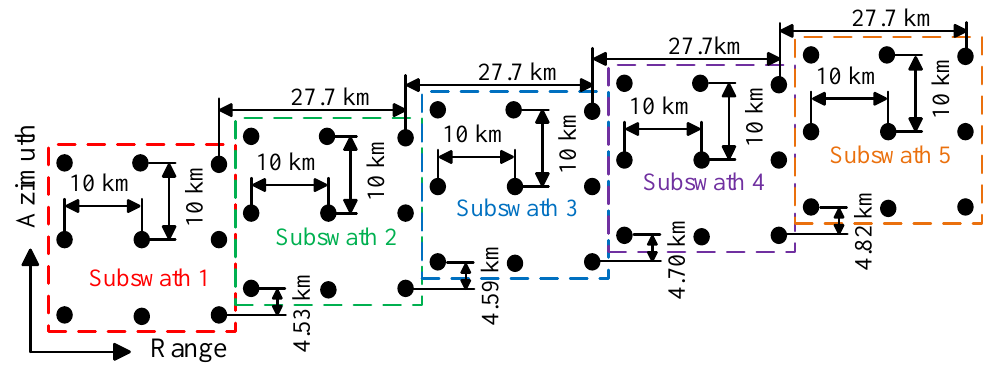
Figure 5. Diagram of simulated targets